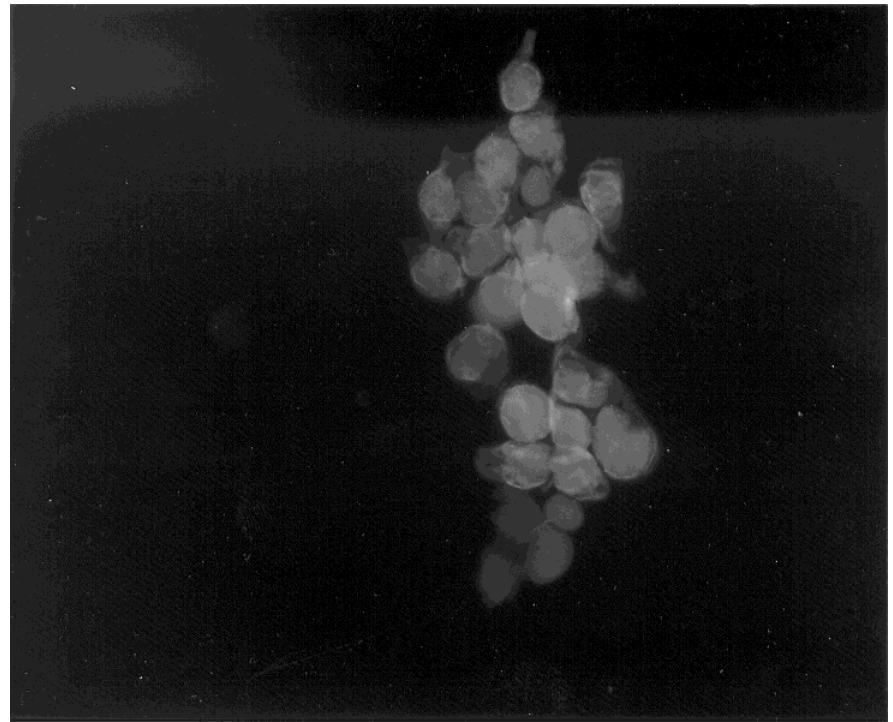
Fig. 4. Suspension of intact cells obtained from a breast carcinoma by mechanical disaggregation. Cells were labelled with an antibody to cytokeratin 8 and 18 (CAM5.2-FITC, green fluorescence in the cytoplasm) and Propidium Iodide (red fluorescence in the nucleus) (original magnification ×